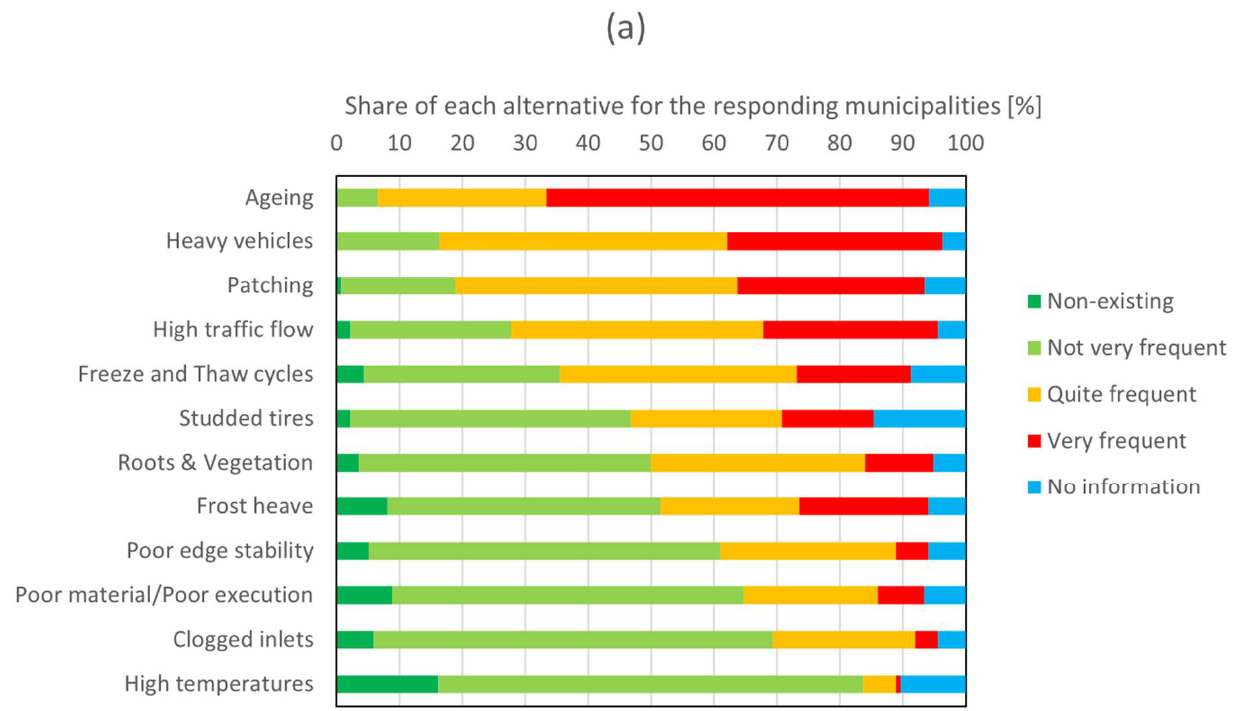
Figure 6. Correlation of the problematic frequency of ( a ) surface unevenness, ( b ) edge deformation, ( c ) potholes, and ( d ) transverse cracks on municipal cycle paths, with respect to the population size of the biggest urban area in each municipality. Note that the x-axis is logarithmic. The municipalities were also asked to state which factors they, in their professional opinion, considered to be the most common causes of distress on streets and cycle paths. The results are shown in Figure 7.